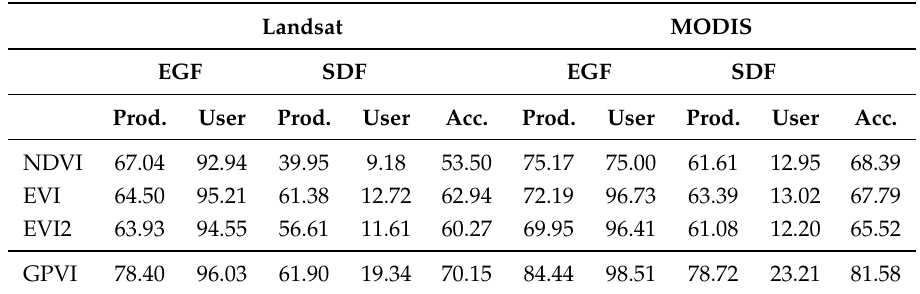
Table 4. Normalized accuracies ( Acc. ) and user’s ( User ), and producer’s (Prod.) accuracies per class for evergreen forest ( EGF )/semi-deciduous forest ( SDF ) discrimination.